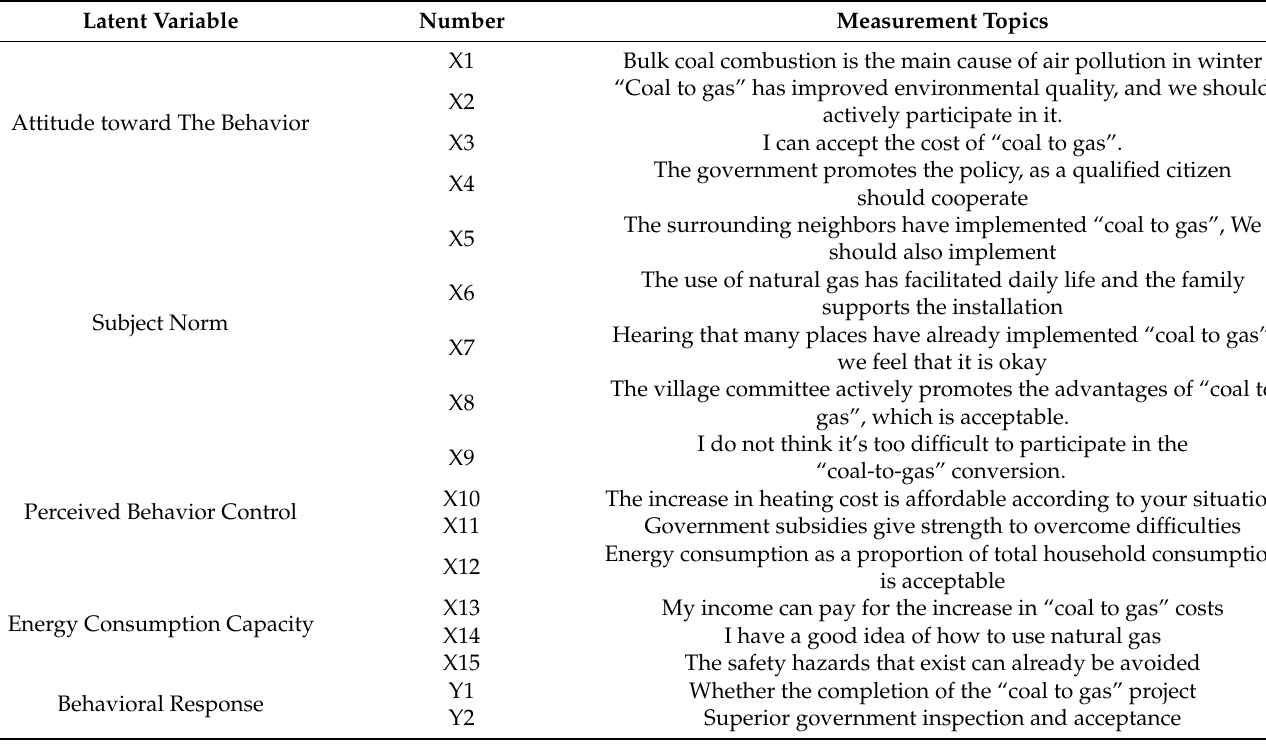
Table 1. Design of the scale of Farmers’ behavioral